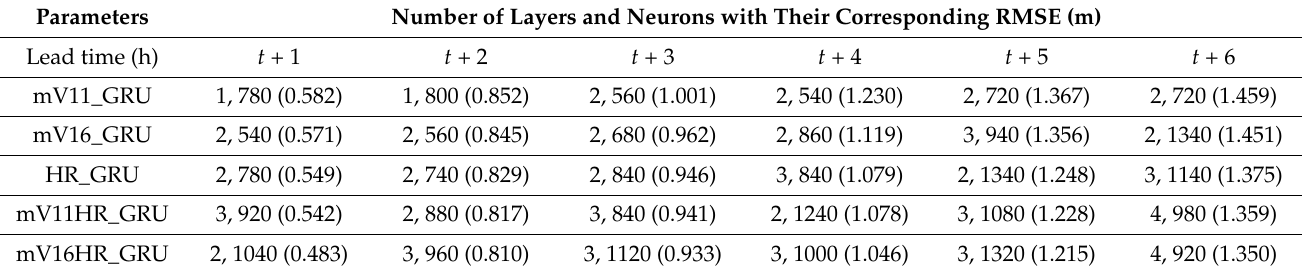
Table 3. Parameter calibrations for the number of GRU layers and number of neurons in a GRU layer at the Longdong buoy. Parameters Number of Layers and Neurons with Their Corresponding RMSE (m)